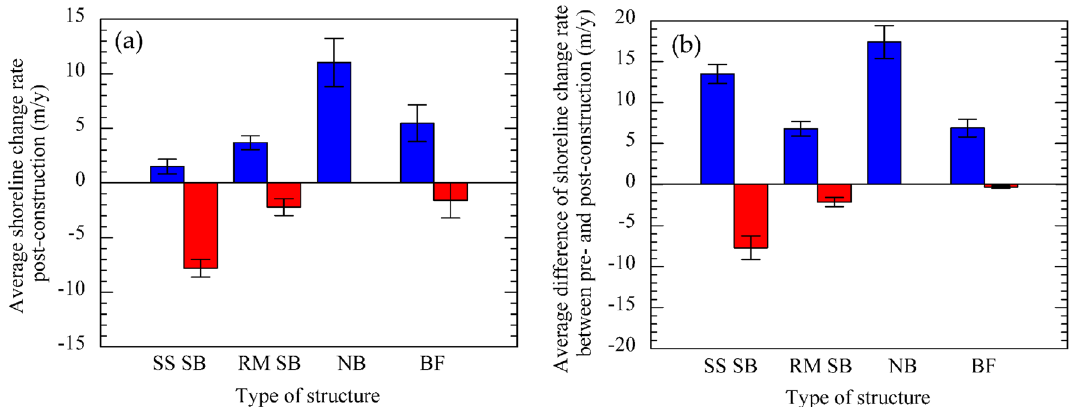
Figure 4. ( a ) Average shoreline change rates after construction of each structure. ( b ) Average differences in shoreline change rates before and after construction of each structure. NB is a nearshore breakwater, BF is a bamboo fence, and SS-SB and RM-SB are sand-sausage-submerged breakwater and rubble-mound submerged breakwater,